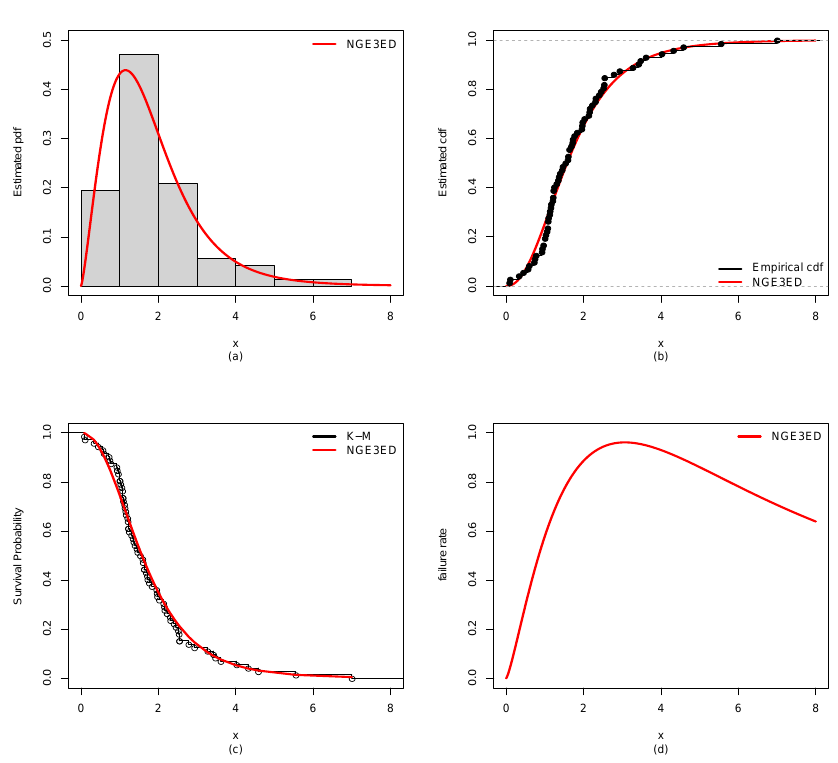
Figure 9. Estimated ( a ) pdf, ( b ) cdf, ( c ) Kaplan–Meier (K-M), and ( d ) hazard rate for guinea-pig data.